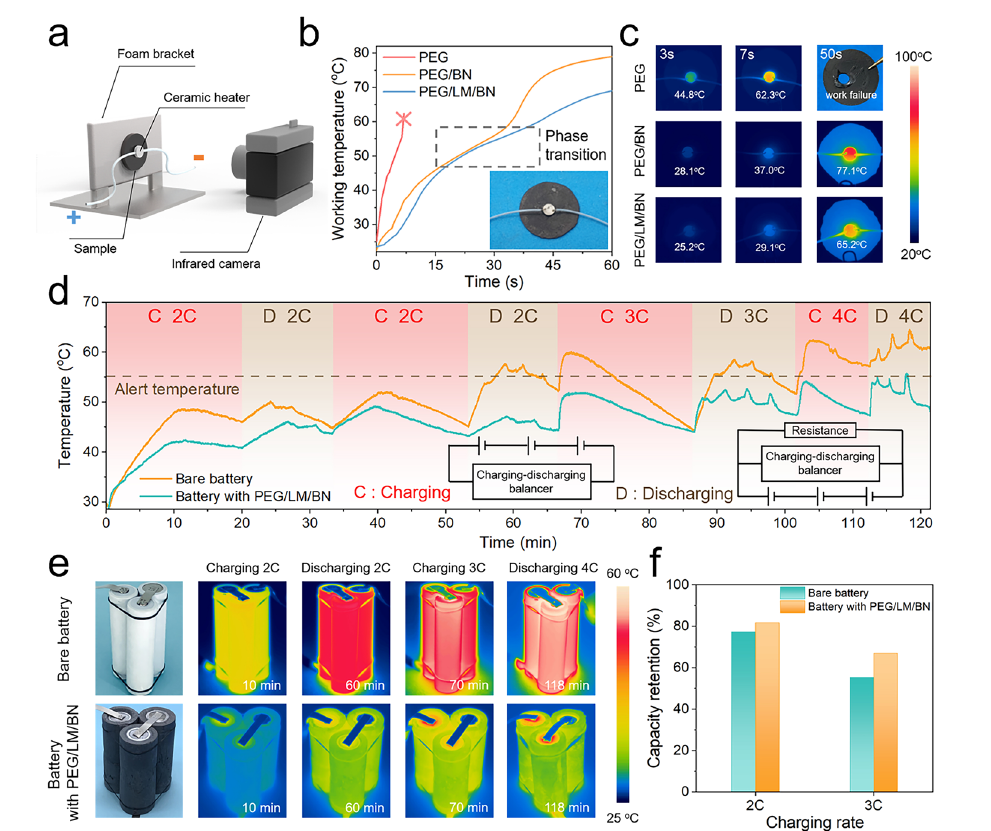
Fig. 5 a Schematic of the test system used to investigate heat-dissipation performance including a powerful ceramic heater simulating local- ized overheating and an infrared (IR) camera recording the surface temperature of the sample. b Working temperature of the ceramic heater versus working time when thermally managed by pure PEG, PEG/BN composite (loading content of 30 vol%) and PEG/LM/BN composite (loading content of 30 vol%). The inset image is the digital photograph of a ceramic heater thermally managed by the PEG/LM/BN composite. c IR images at different heating times for thermal management of a point-like heat source by pure PEG, PEG/BN composite and PEG/LM/BN composite. d Battery temperature profiles for bare battery pack and battery pack with PEG/LM/BN thermal regulator under high-C charging and discharging. The inset shows the circuit connection. e Digital photographs of bare battery pack (top) and battery pack with PEG/LM/BN ther- mal regulator (bottom) and their IR images during the process of charging and discharging. f Capacity retention of bare battery and battery with PEG/LM/BN thermal regulator at different charging